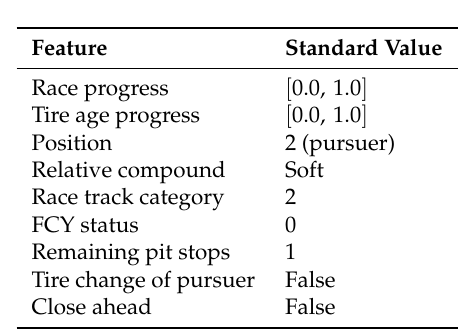
Table 13. Standard values used to create the example race for the feature impact analysis of the pit stop decision